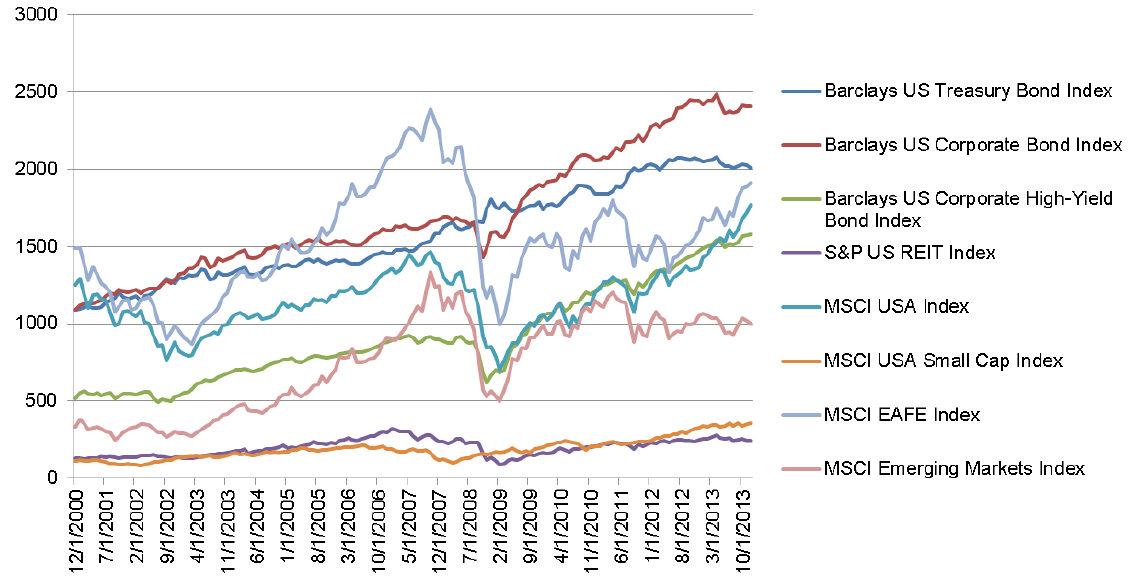
Figure 1. Key indices used in the study for the period